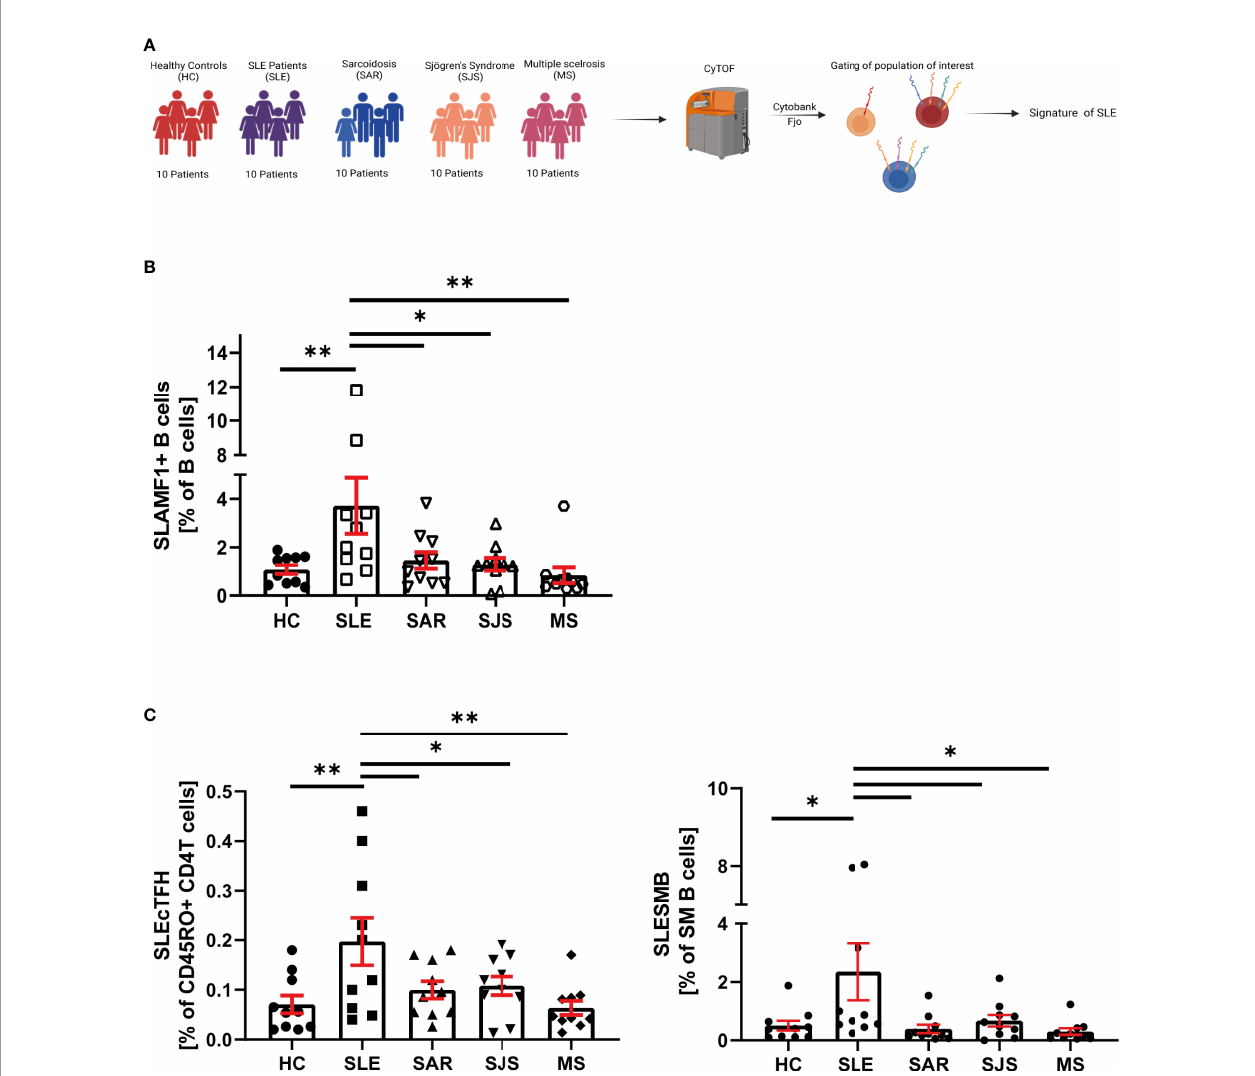
FIGURE 5 | SLE speci fi city of SLAMF immune signature. (A) Graphical abstract of technical approach. (B) Frequency of SLAMF1+ B cells over B cells in cohort 2 (n=10 per group, one way ANOVA with Dunnett ’ s multiple comparison test on log10 transformed data, *p=0.02, **p=0.002, ***p<0.001). (C) Frequency of circulating T follicular helper cells expressing SLAMF1+3+5+6 over memory CD4+ T cells (left) and switch memory B cells expressing SLAMF1+3+5+6+ over SM B cells (right) in cohort 2 (n= 10 per group, one way ANOVA with Dunnett ’ s multiple comparison test on log10 transformed data, *p=0.02,